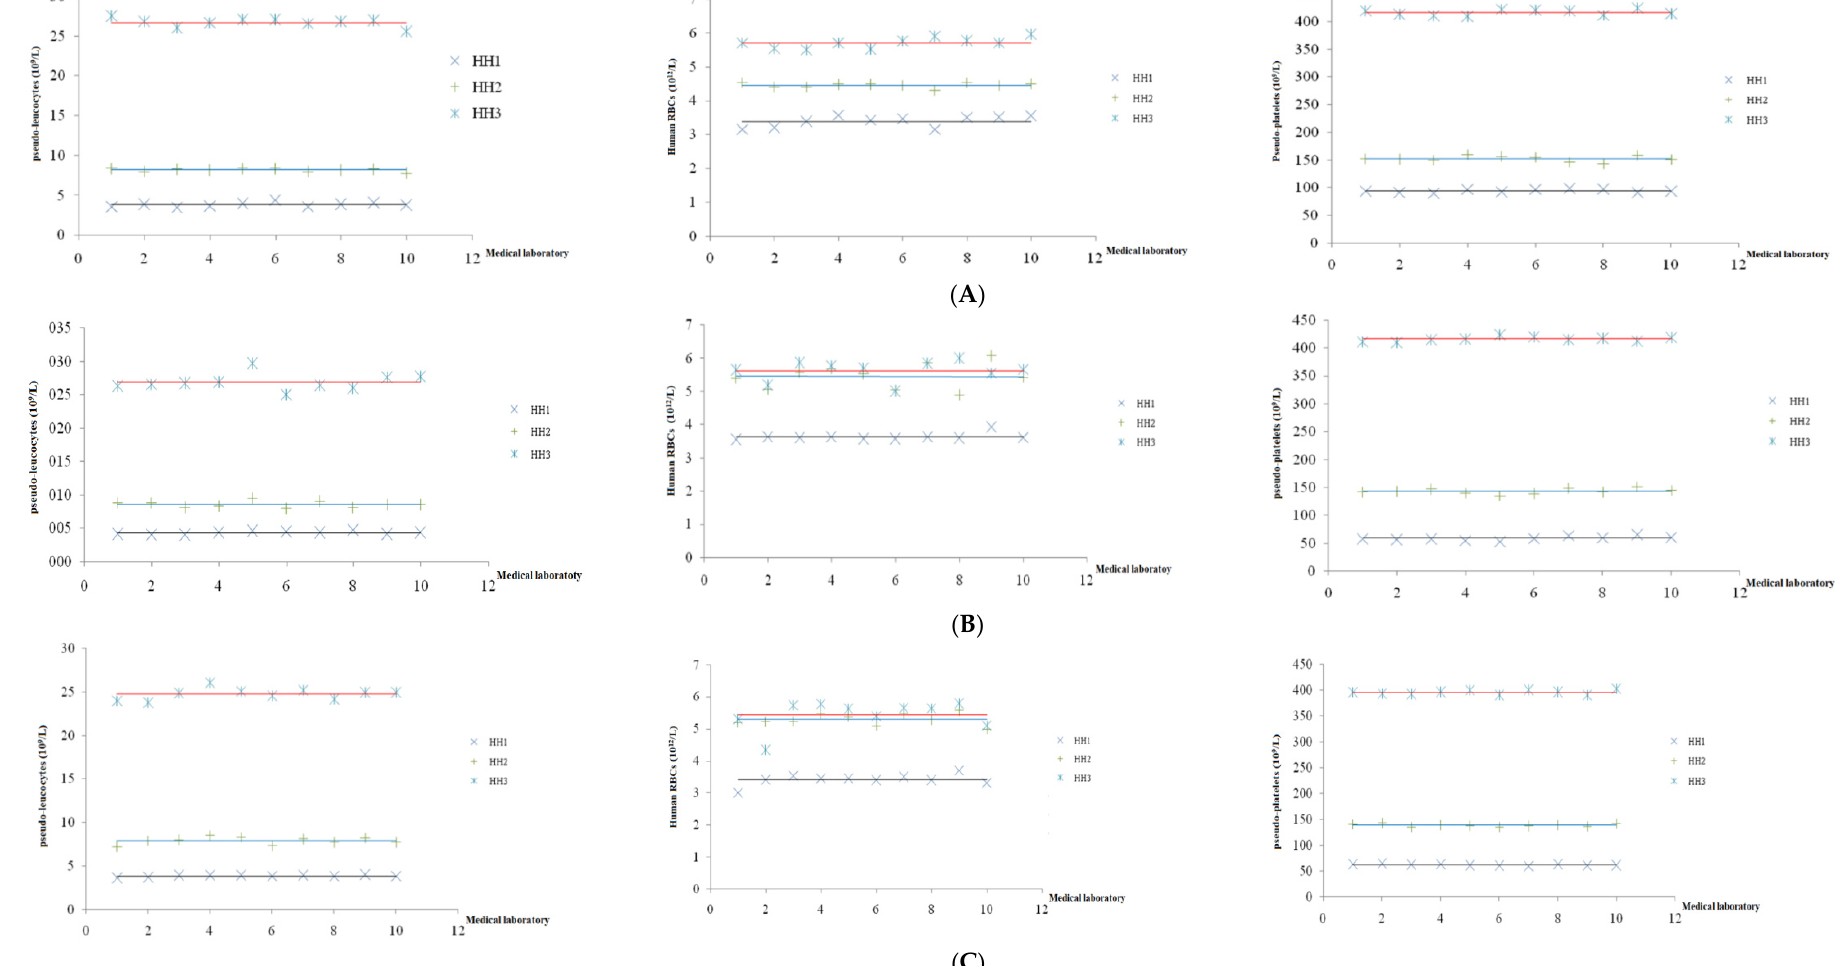
Figure 1. The results of the analysis of the assigned value at the concurrency levels of hematological reference samples run on the ABX Micros 60 ( A ), Celldyn 1700 ( B ) and Mindray BC 2000 ( C ). The three lines represent the mean (assigned value) for the low, normal, and high concentrations, respectively, and 10 points represent the results of 10 laboratories.